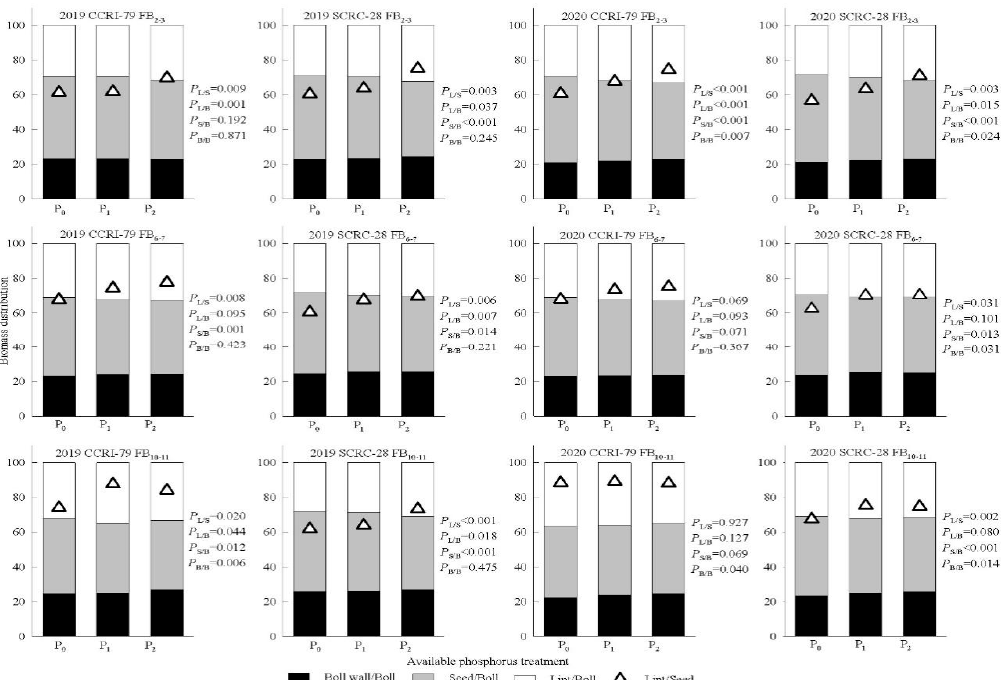
Figure 11. The effect of soil available phosphorus (AP) on cotton boll biomass partitioning in the boll wall, seed, and lint in 2019 and 2020. The subscripts of L/S, L/B, S/B, and B/B represent lint:seed, lint:boll, seed:boll, and boll wall:boll ratios,